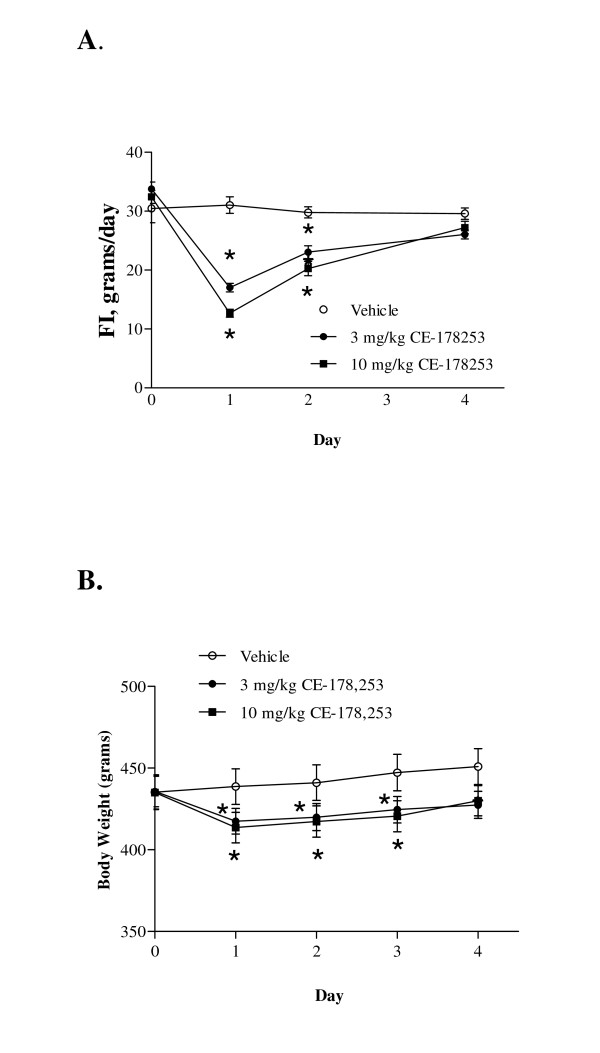
Effect of CE-178253 on FI (7A) and BW (7B) in chow-fed rats. FI and BW were measured in chow-fed rats, treated after once daily administration of veh. (0.5% MC) or CE-178253 at either 3 mg/kg or 10 mg/kg p.o. Initial and final body weights of veh-treated rats were 435 ± 11 g and 451 ± 12 g (n = 8), respectively. Initial and final body weights of 3 mg/kg CE-178253-treated rats were 436 ± 9 g and 427 ± 9 g, respectively. Initial and final body weights of 10 mg/kg CE-178253-treated rats were 435 ± 11 g and 430 ± 10 g, respectively. FI data shown are the total amount of food consumed expressed in grams for each day of treatment. The mean ± SEM (n = 6-8/group) is shown. * = p < 0.05 vs. veh.